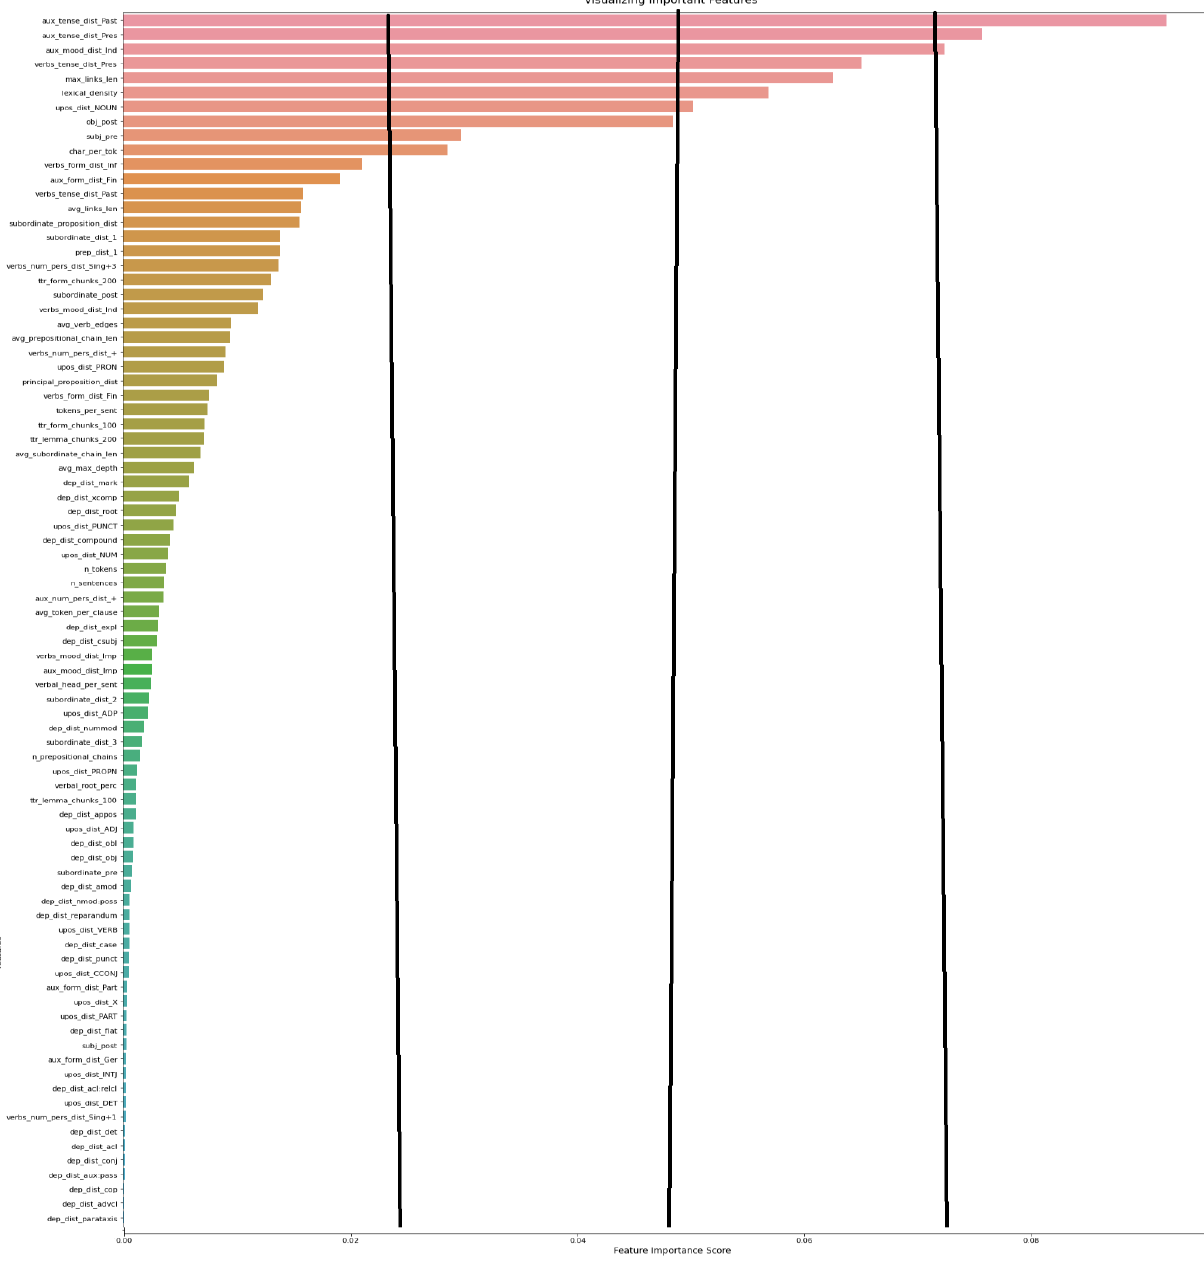
Figure 2. Variable importance plot of the RF genre model. NOTE: The x-axis shows the permutation relevance (mean decrease in accuracy) of each feature; the y-axis lists the features of the genre model.